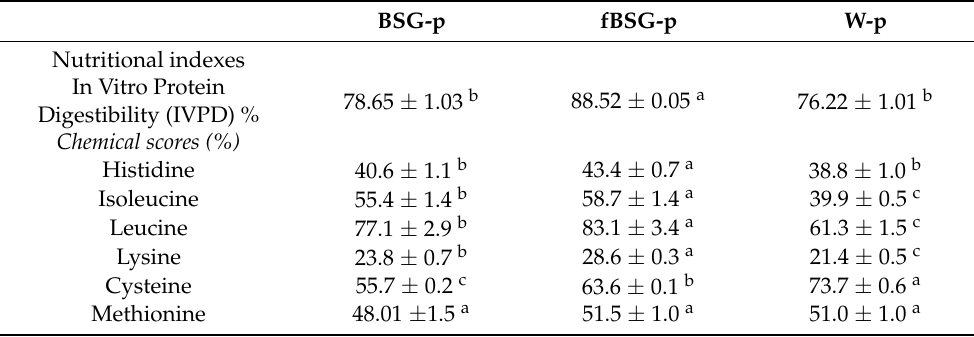
Table 4. In vitro protein and starch digestibility and nutritional indexes of pasta containing fermented and native brewers’ spent grain: BSG-p, pasta containing native brewers’ spent grain (15% wt/wt in replacement of semolina); fBSG-p, pasta containing fermented brewers’ spent grain (15% wt/wt in replacement of semolina); W-p, pasta made with durum wheat